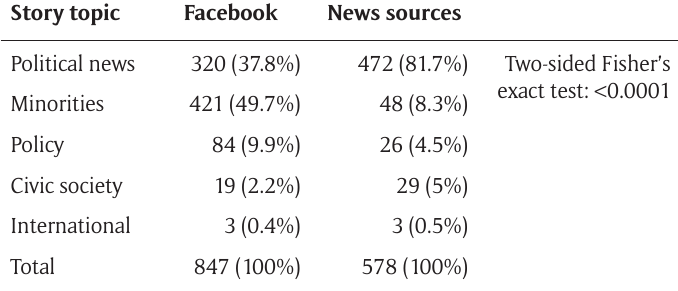
Table 2: Distribution of disagreement per story topic and